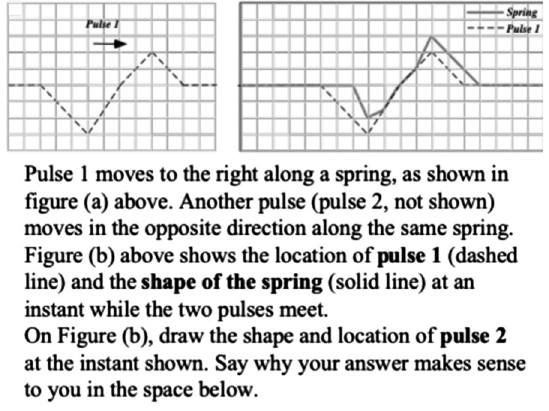
FIG. 5. The predict-style question on superposition (the pulse subtraction question). This question is modified from Kryjevskaia, Stetzer, and Heron [22].